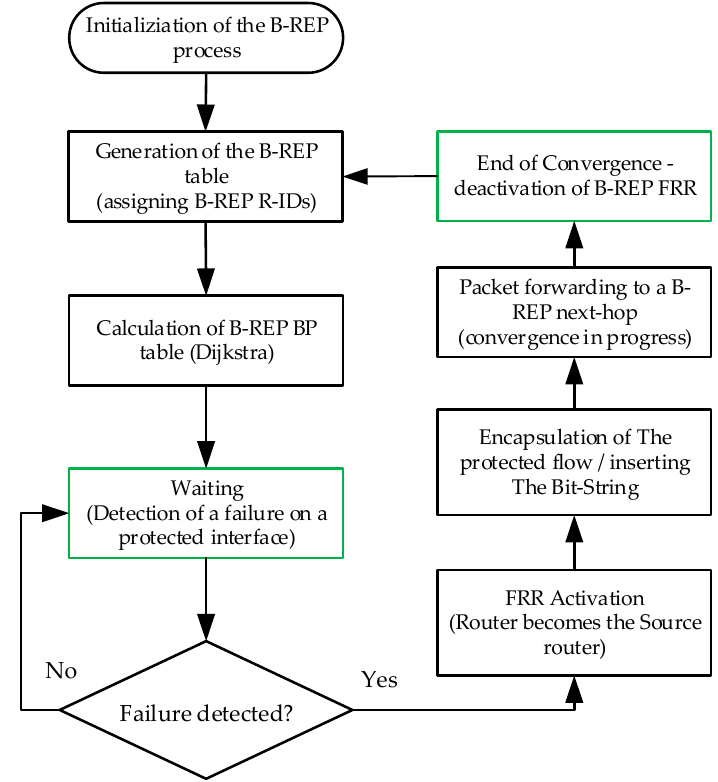
Figure 9. Example of a modified bit-string.